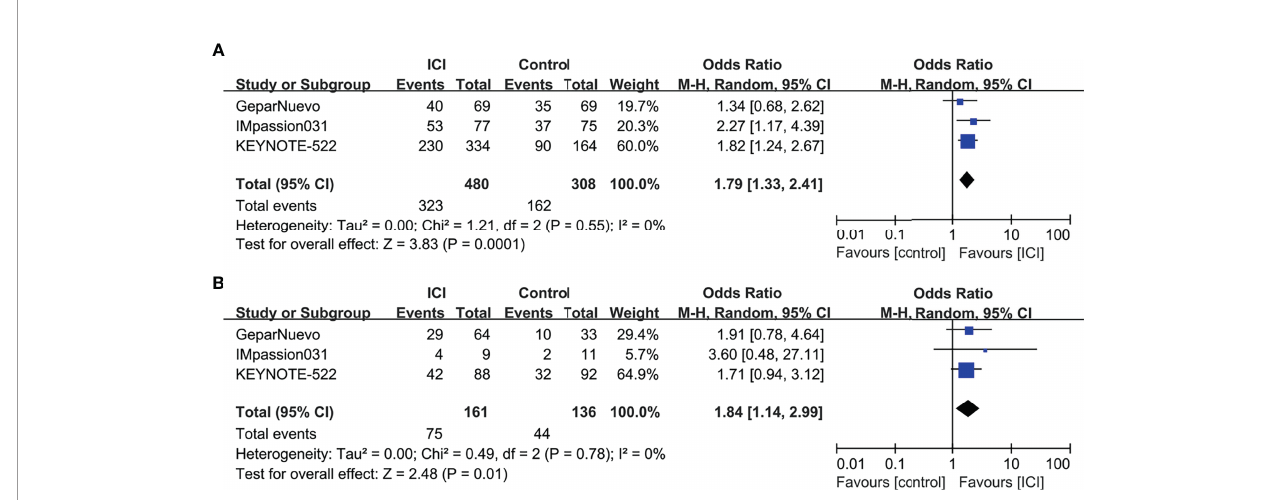
FIGURE 3 | Forest plots of subgroup meta-analyses of pCR based on PD-L1 status. (A) ICI-containing neoadjuvant therapy compared with ICI-free neoadjuvant therapy in TNBC patients with PD-L1-positive tumors. (B) ICI-containing neoadjuvant therapy compared with ICI-free neoadjuvant therapy in TNBC patients with PD- L1-negative tumors.